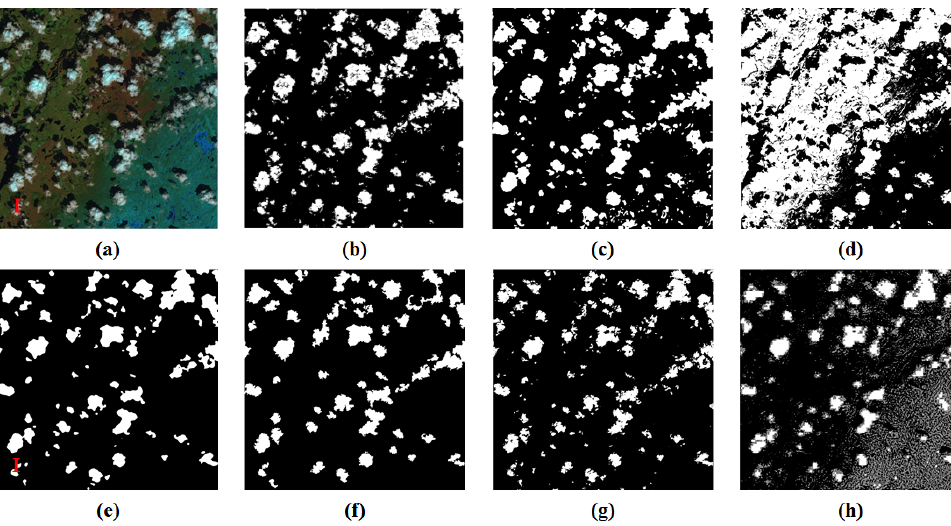
Figure 4. Cloud detection maps of the compared methods: ( a ) Input images labeled I from the Landsat 8 dataset, ( b ) reference detection map, ( c ) proposed, ( d ) K-means, ( e ) progressive refinement scheme (PRS), ( f ) principal component analysis network (PCANet), ( g ) support vector machine (SVM), and ( h ) scene learning